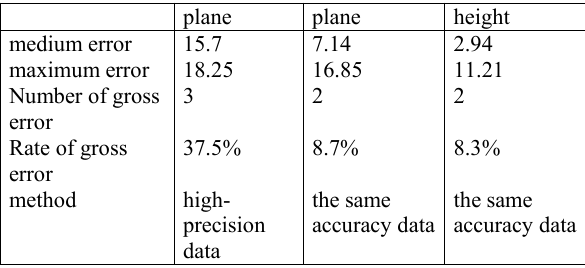
Table 7. Statistical results of field 3